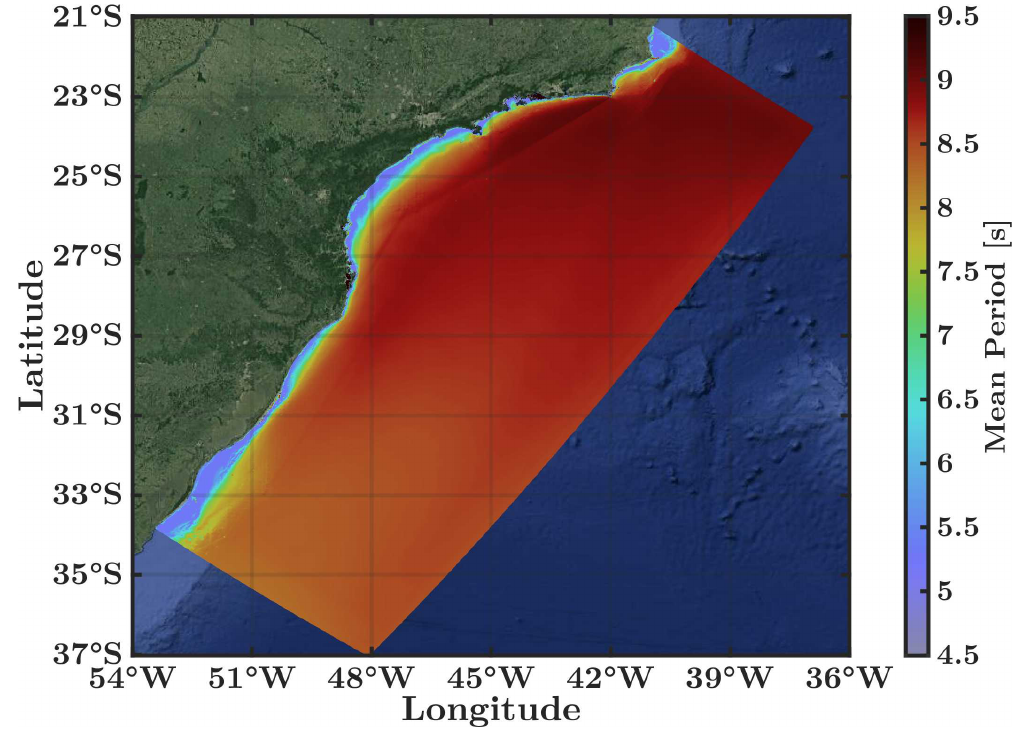
Figure 7. Mean value of mean period T m (s) over 18